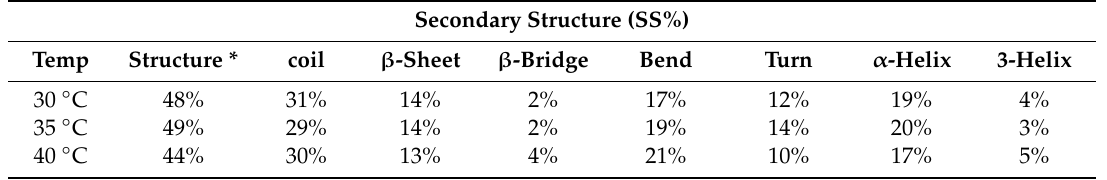
Table 3. Percentage of residues participated in average structure formation.